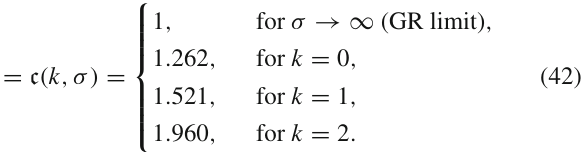
Fig. 4 The m – N parameterspace,fortheself-interactingglueballdark matter, in the σ → ∞ GR limit. The black (light gray) band shows the gravitational wave peak frequency to be detected by the LIGO (eLISA) experiment, whereas the gray band shows the gravitational wave peak frequency emitted from SU( N ) (Schwarzschild) dark star mergers